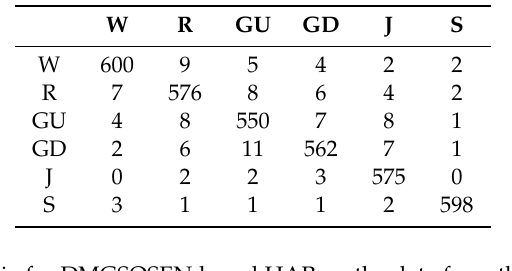
Table 7. Confusion matrix for DMGSOSEN-based HAR on the data from the chest when the initial pool size is